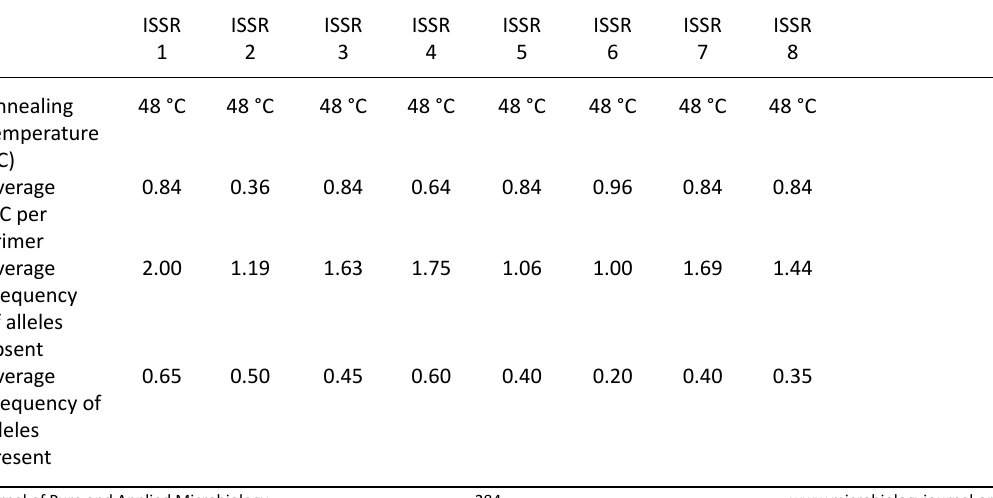
Table 3. Data on annealing temperature (°C), average pic per primer, average frequency of alleles absent, and average frequency of alleles present for ISSR markers ISSR ISSR ISSR